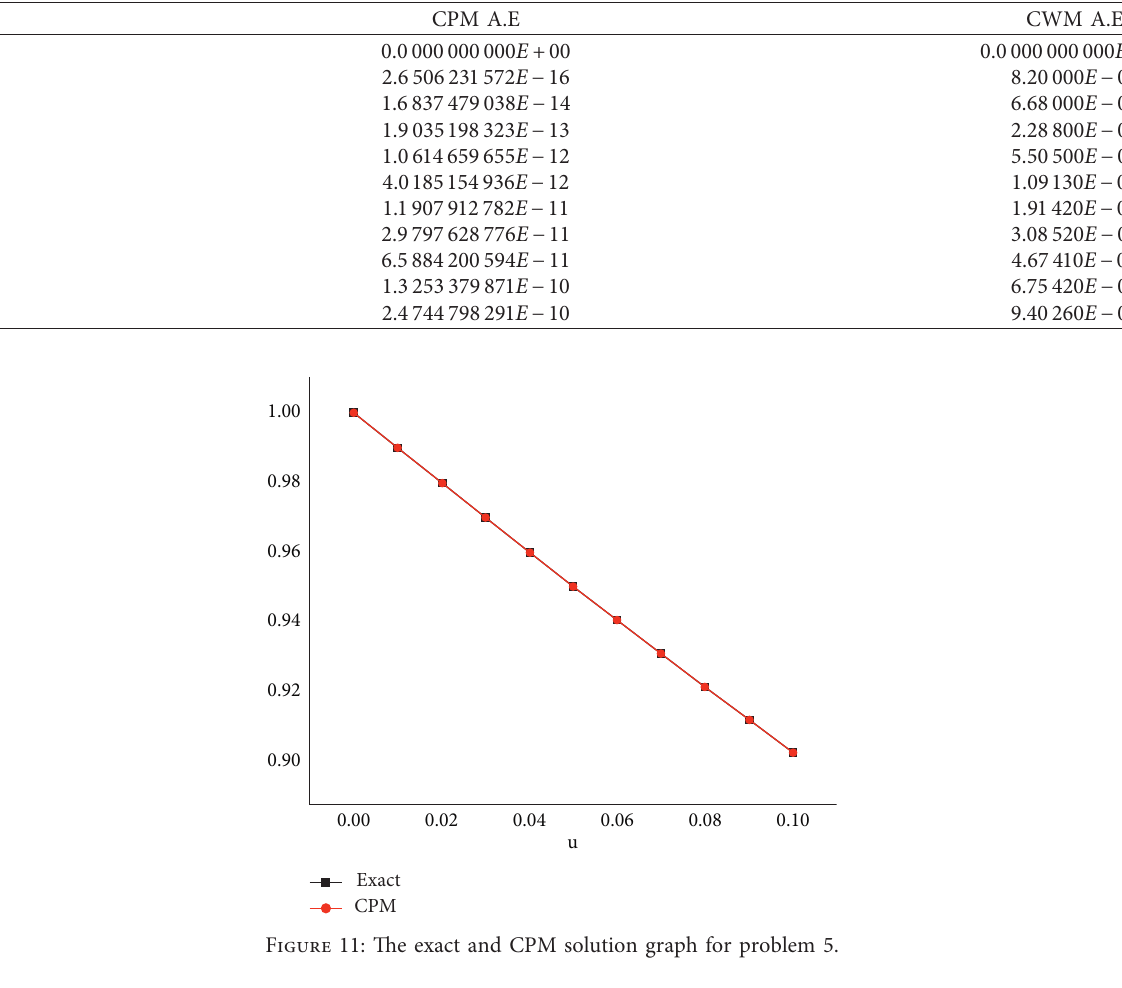
Table 10: Absolute error (A.E) comparison of CPM and other different methods of problem 5 at m � 6.